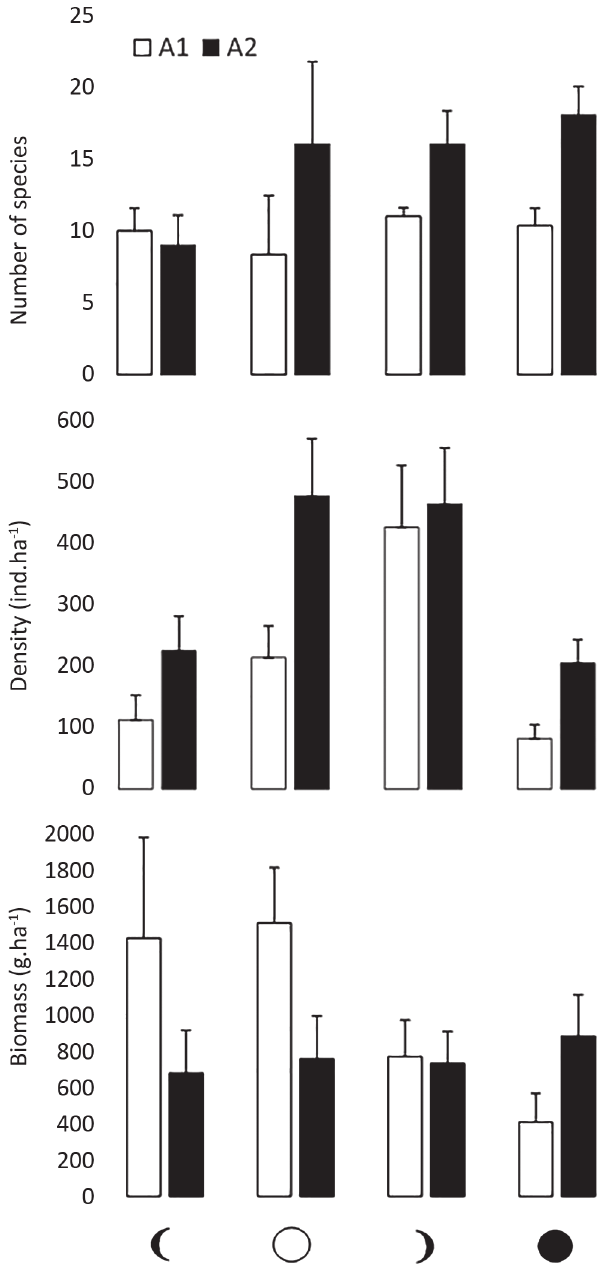
Fig. 2 . Mean + Standard Error (SE) of number of species, total density (ind.ha -1 ) and biomass (g.ha -1 ) of fishes as a function of the lunar phases from left to right in the horizontal axes (crescent, full, weaning and new